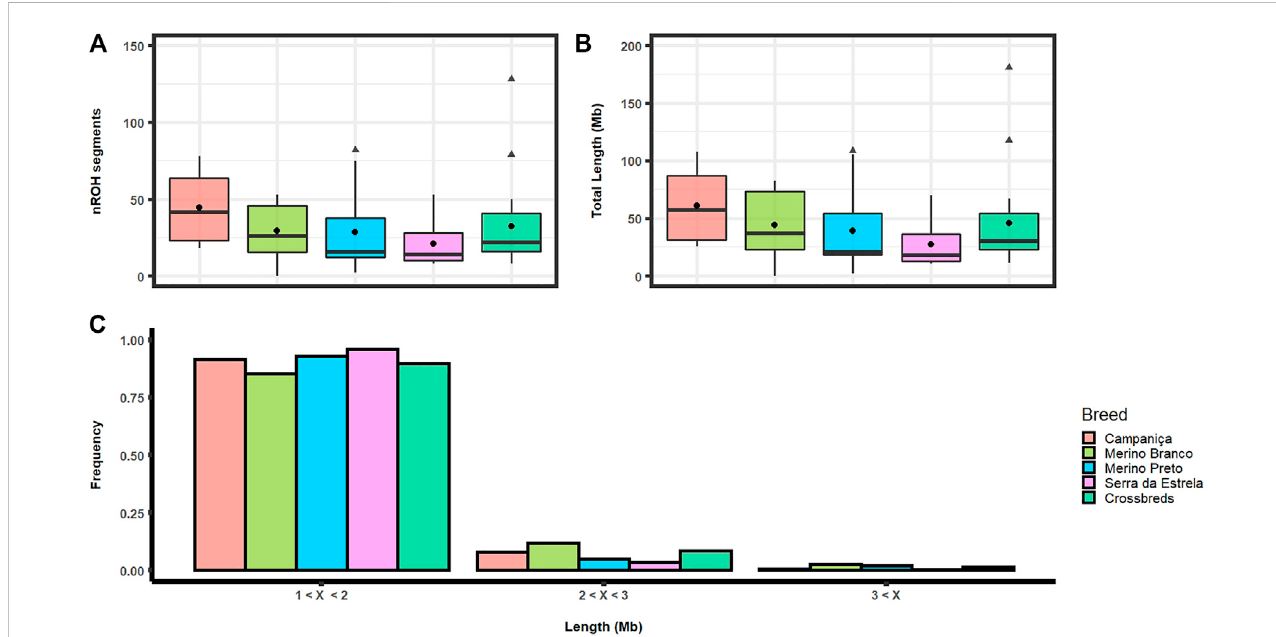
FIGURE 3 Runs of homozygosity (ROH) in Portuguese sheep. (A) Boxplot graph depicting the average number of ROH segments (nROH) per animal in each population. Mean values are represented by black circles and outliers by triangles; (B) Boxplot graph depicting average ROH length in each population. Mean values are represented by black circles and outliers by triangles; (C) Frequency distribution of the number of ROH by different length categories, i.e., short (1 – 2 Mb), medium (2 – 3 Mb) and large (over 3 Mb) for each